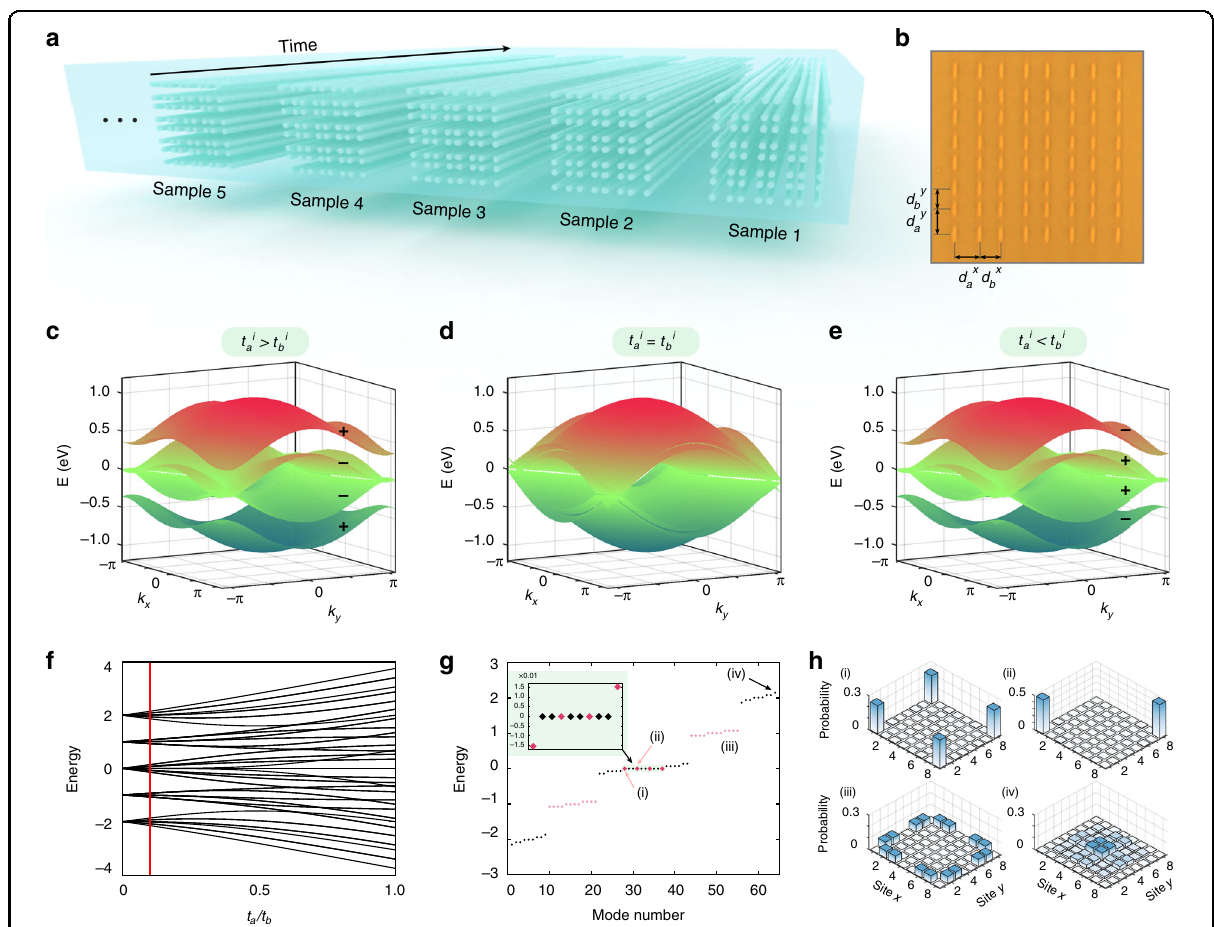
Fig. 1 Schematic of topological photonic chip and the band structure of the lattice. a The topological lattices are integrated into a single photonic chip. b The microgram of the photonic lattice crosssection. The parameters are d a = 13 μ m and d b = 11 μ m. c − e The band structures of the C 4 symmetric lattices. There is a band inversion process between two gapped phases separated by gapless con fi gurations for the C 4 symmetric ¼ t i lattices when t i . ( e ). f − h The spectrum of the fi nite C 4 symmetric lattices. The red lines in ( f ) point out the parameter t a / t b picked in ( g ). The inset a b shows the perturbation of symmetry induced from the fi nite-size system, which renders the corner modes away a bit from zero energy. The spatial distribution of corner states, marked in red in ( g ), is presented in inset (i) and (ii) of ( h ). The spatial distributions of edge state, marked in light red in ( g ), and bulk state are shown in inset (iii) and (iv) of ( h )